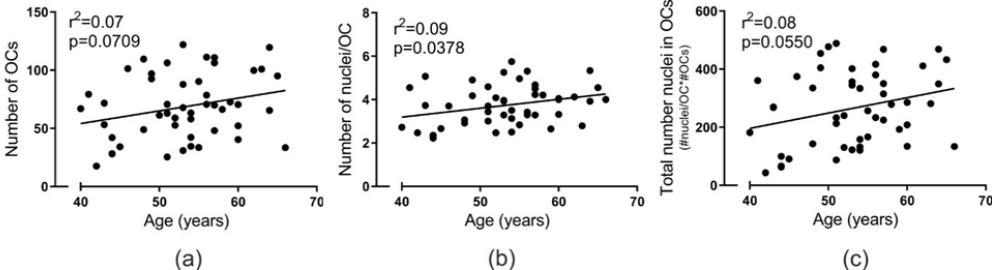
Figure 2. Fusion potential of OCs in vitro increases with donor age. The relation between donor age and ( a ) the mean number of OCs (per vision field), ( b ) the mean number of nuclei per OC, and ( c ) the total number of nuclei in OCs (per vision field). Statistics: correlation analyses were performed using Pearson’s correlation (r 2 ). An outlier was removed in ( b ), based on Grubbs’ test for outliers (alpha = 0.01). Each point represents the results obtained from OCs in vitro generated from an individual donor ( n = 49).